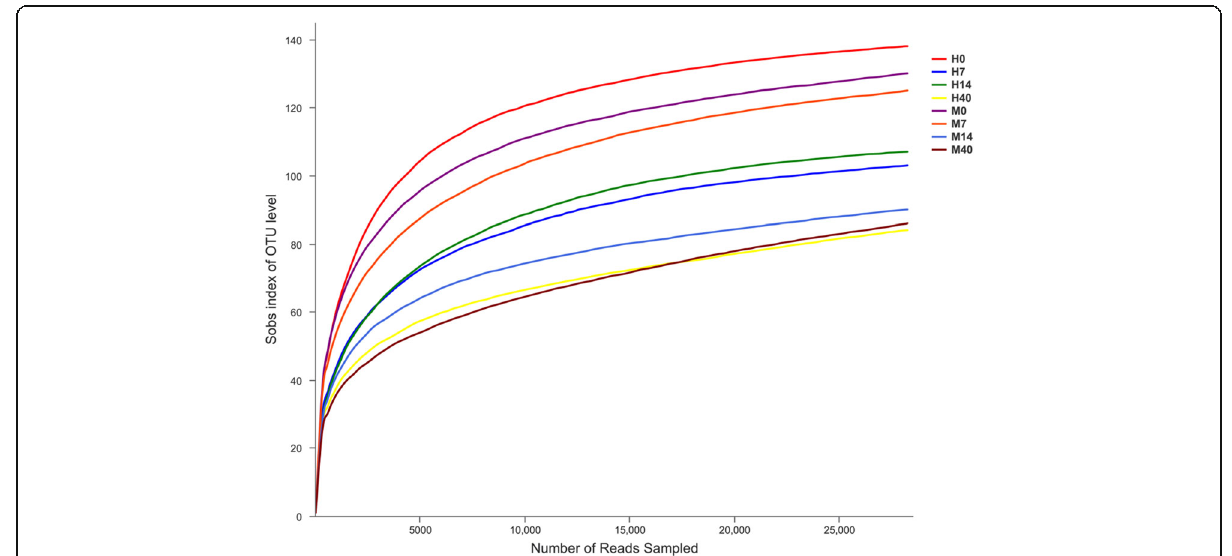
Fig. 2 Rarefaction analysis of the samples. Rarefaction curves of OTUs from different samples clustered at 97% sequence